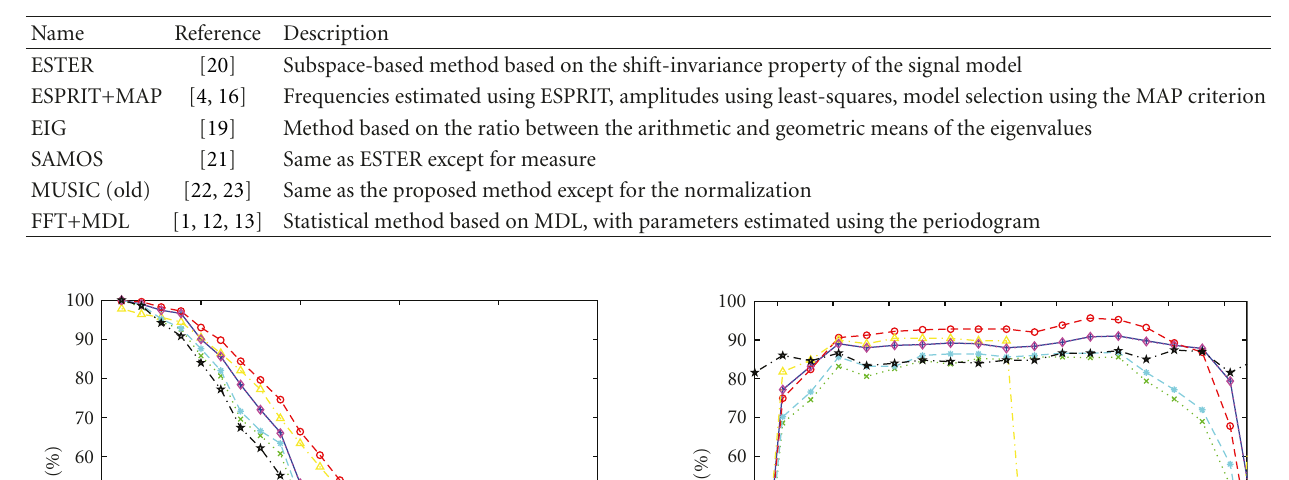
Table 1: List of reference methods used in the experiments with short descriptions and references to literature.